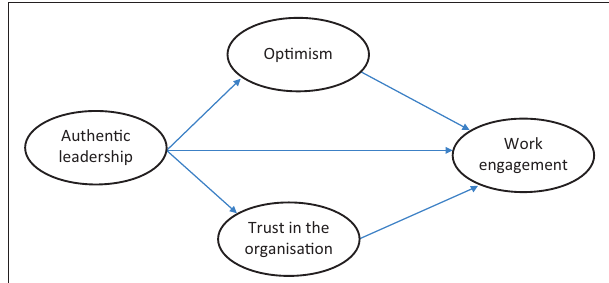
FIGURE 1: The research